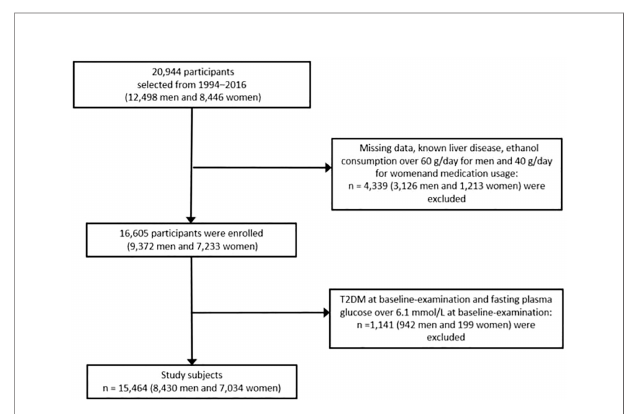
FIGURE 1 | Flow chart showing the exclusion criteria of participants. T2DM, type 2 diabetes